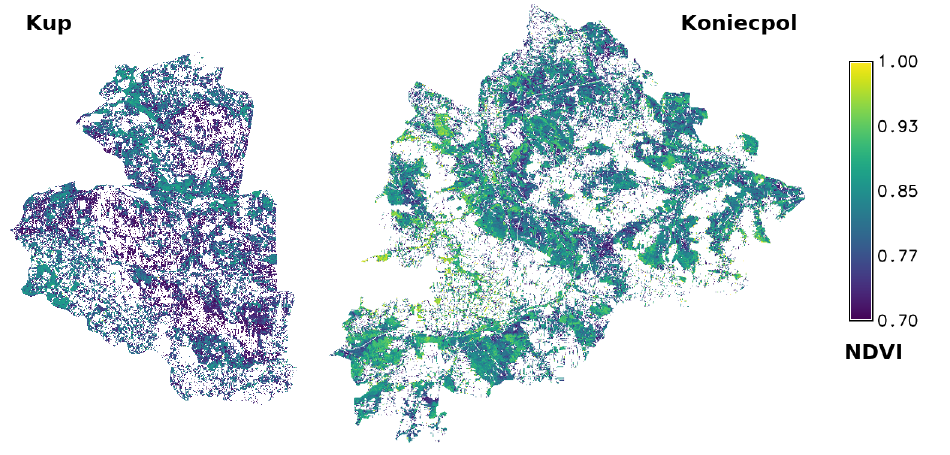
Figure 3. Calculated NDVI for the Kup ( left ) and Koniecpol ( right ) forest